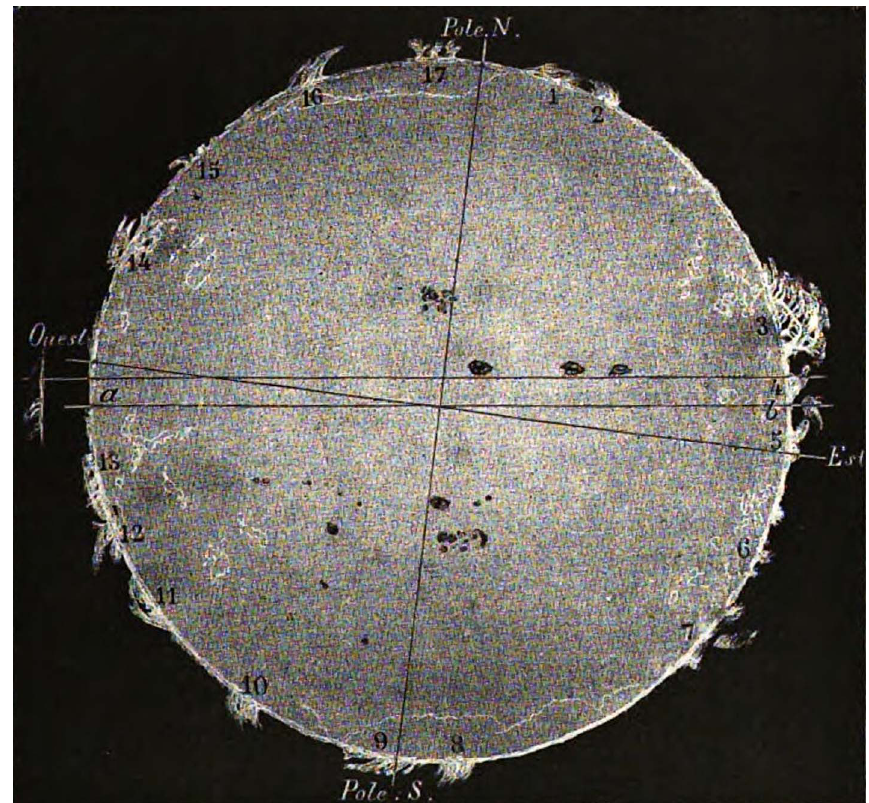
Fig. 2. Illustration of the solar observations made by Secchi on 23 July 1871 between 8:30 and 9:55 am. Prominences (white regions from solar limb numbered from 1 to 17), sunspots (black regions on the solar disc), and faculae (white regions on the solar disc) were recorded. Inclined black lines indicate the solar axes ( “ Est ” means East, “ Ouest ” is West, “ Pole N. ” and “ Pole S. ” indicate the solar north and south, respectively). The horizontal black lines are upper line – a reference indicated by Secchi to obtain the position of the celestial equator, and lower line – its parallel diameter given by “ a – b ” line representing the celestial equator [source: Secchi, 1875, p. 131]. Table 1. Some example lines of the machine-readable version presented in this work on the sunspot and prominence observations made by Secchi published in Le Soleil . The fi rst column shows the number of each solar rotation in Roman numerals, followed by the date (year-month- day format) when the solar rotation starts, the number of prominences in the northern and southern hemisphere respectively, the number of observation days of prominences, the daily average of the prominence number, the number of new sunspot groups observed for each solar rotation, the sunspot area (one unit is de fi ned such as 1 mm in height corresponds to 8 arcseconds and one degree at the limb corresponds to 16 arcseconds), the number of observation days in the case of sunspots, and the daily average of sunspot area. Solar Start Prom. number rotation date